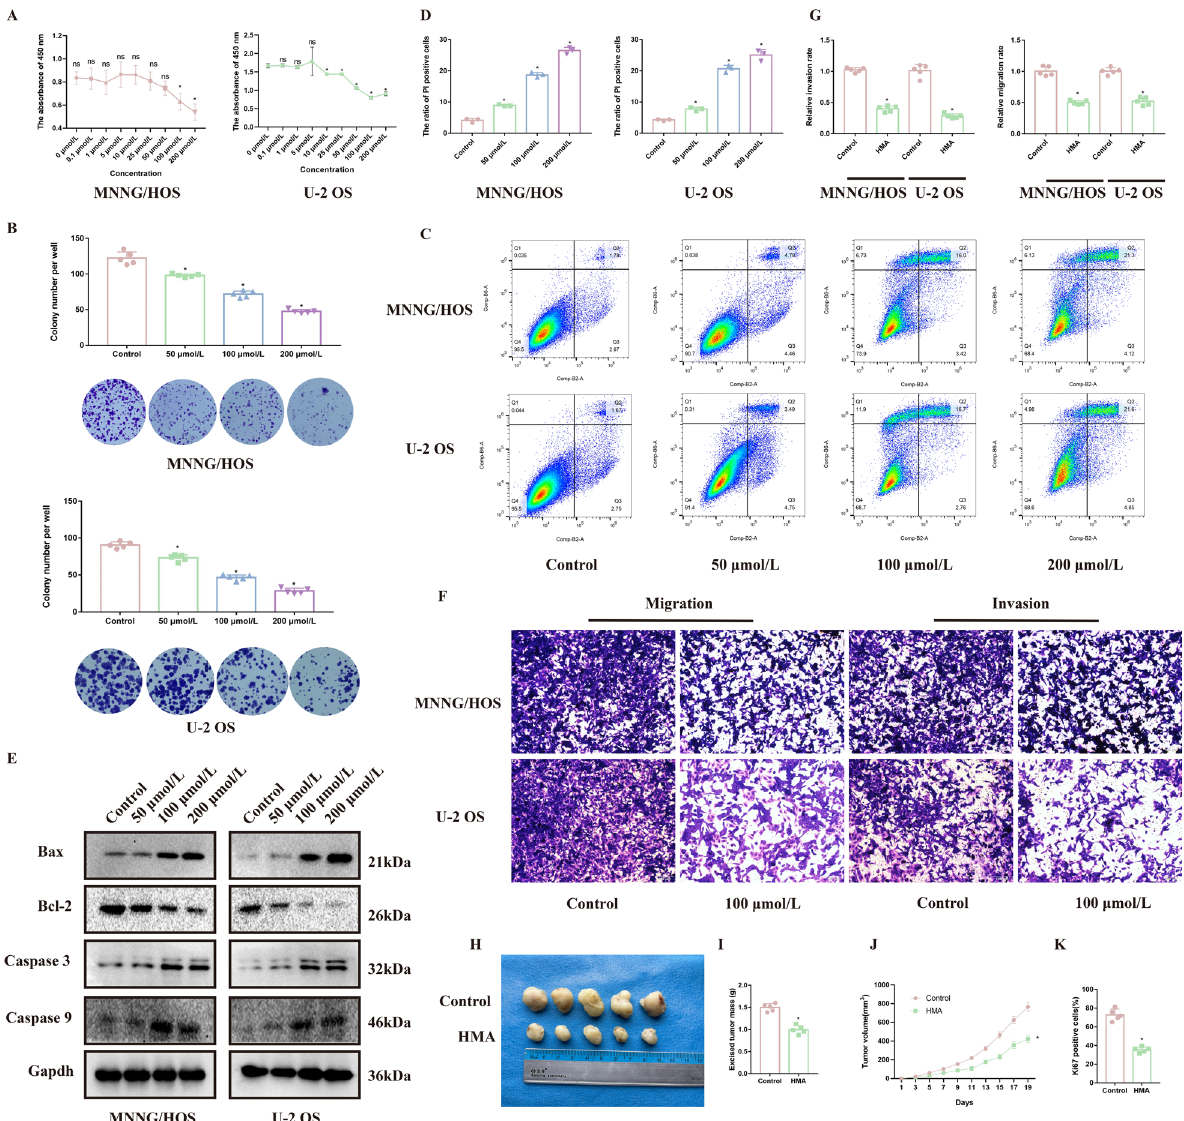
Fig. 1 HMA effectively inhibits the proliferation capacity of osteosarcoma cells: The MNNG/HOS and U-2 OS cells were treated with different concentrations of HMA (0, 0.1, 1, 5, 10, 25, 50, 100, and 200 μmol/L) for A CCK-8 assay to evaluate the viability of the OS cells. Treatment with 0, 50, 100, and 200 μmol/L HMA of the OS cells was conducted for B colony formation assay, C , D Annexin V-FITC apoptosis detection assay, E Western blotting, and F , G transwell assay to detect the various biological behaviors of the OS cells in vitro. H The MNNG/HOS cells were injected subcutaneously into nude mice for xenograft assay. I Tumor growth curve and J excised tumor mass, as indicated. ( K ) IHC scores for Ki-67 staining, as